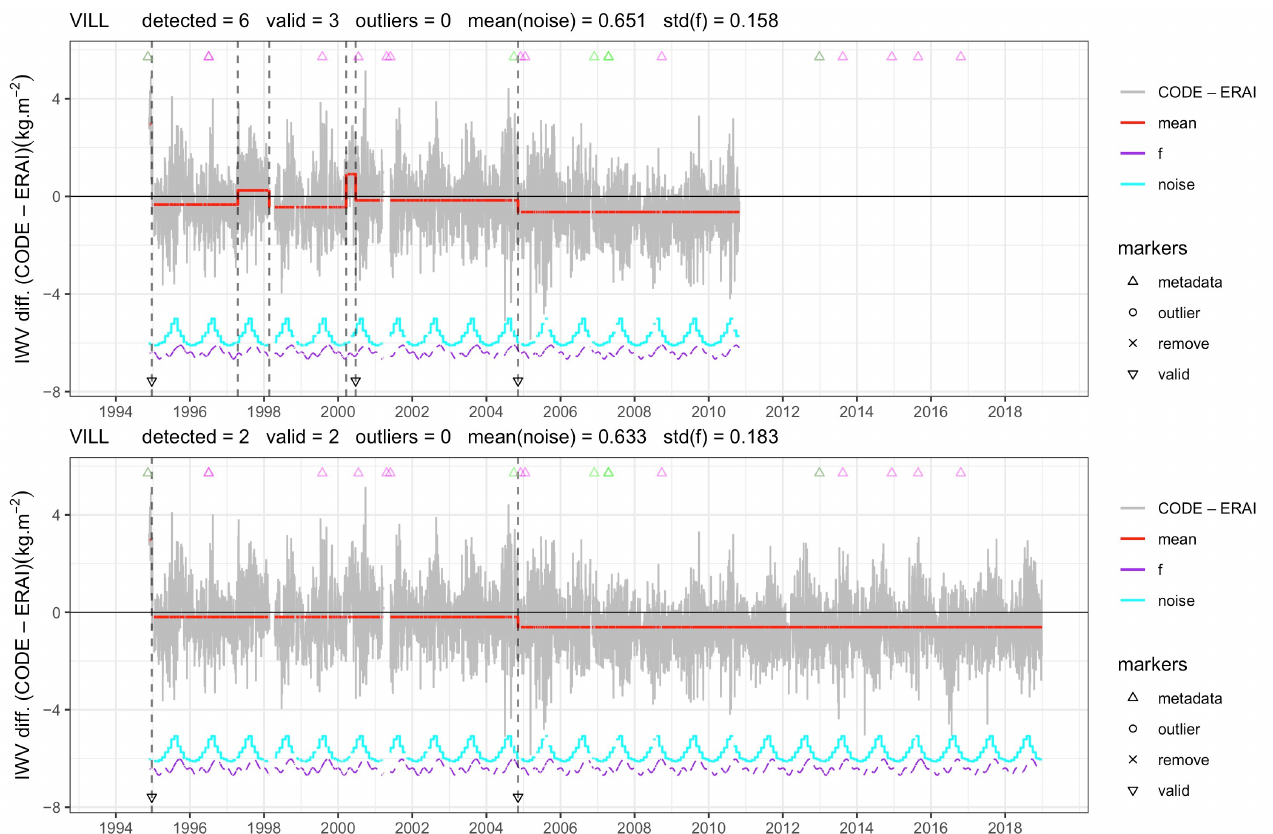
Figure 8. Similar to Figure 4, but for station VILL (Villafranca,